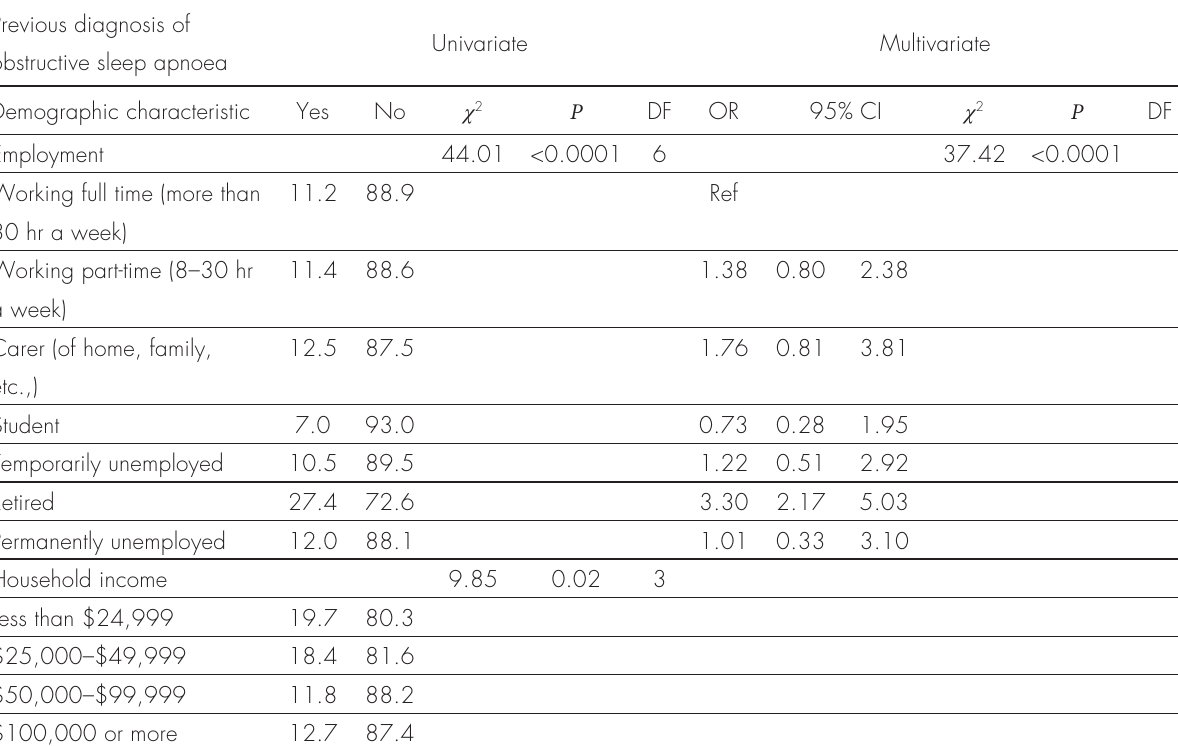
Table IV. Demographic characteristics (gender, age group, education, employment status, annual income) and their associations with previous diagnosis of obstructive sleep apnoea. Previous diagnosis of Univariate Multivariate obstructive sleep apnoea Demographic characteristic Yes No χ 2 P DF OR 95% CI χ 2 P DF Employment 44.01 <0.0001 6 37.42 <0.0001